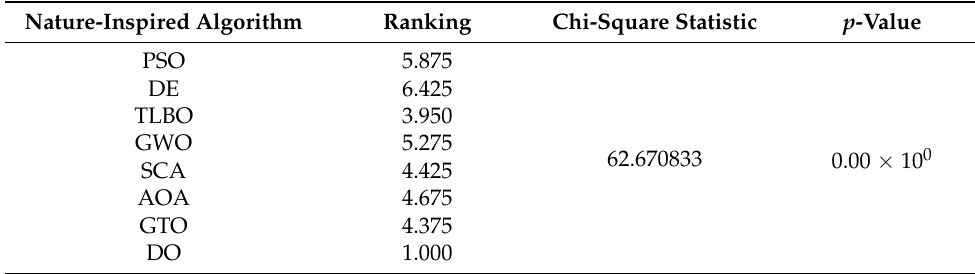
Table 8. Friedman test for multiple comparisons between DO and other nature-inspired algorithms when optimizing the delamination size at the top side.